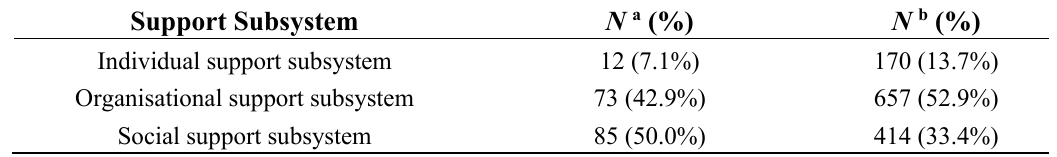
Table 3. Healthcare workers’ expected use of support subsystems.